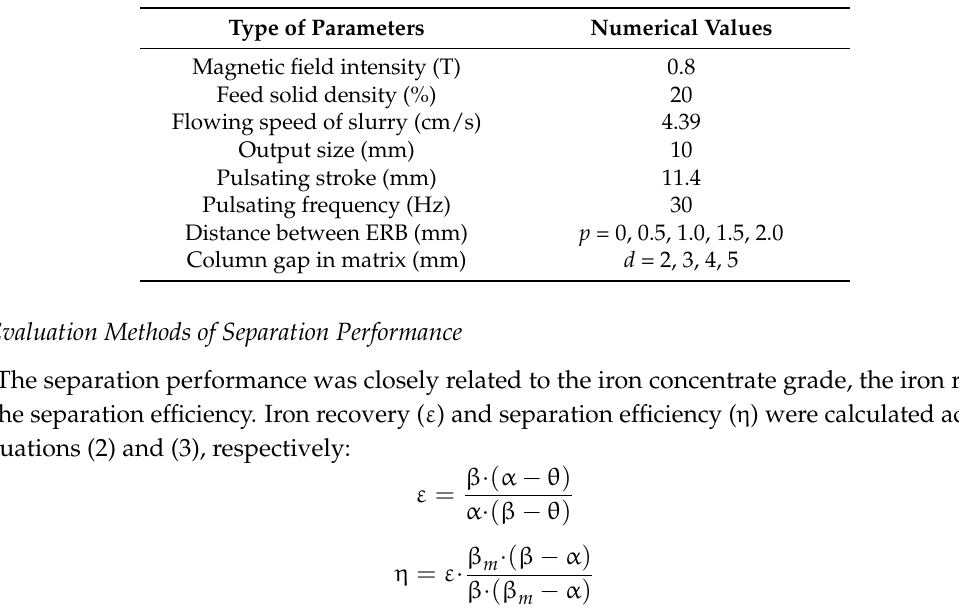
Table 1. Experimental